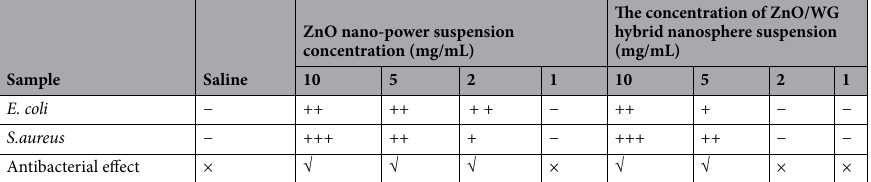
Table 2. Antibacterial effect of ZnO/WG nanospheres on E. coli and S. aureus. While D ≥ 10 mm, and no bacteria colony in the inhibition zone, recorded as +++; while D ≥ 10 mm, but appeared visible colonies in the inhibition zone, recorded as ++; while 10 mm > D ≥ 5 mm, and no colony in the inhibition zone, it is recorded as ++; while 10 mm > D ≥ 5 mm, but appeared visible colonies in the circle, it is recorded as +; while D < 5 mm, recorded as −.